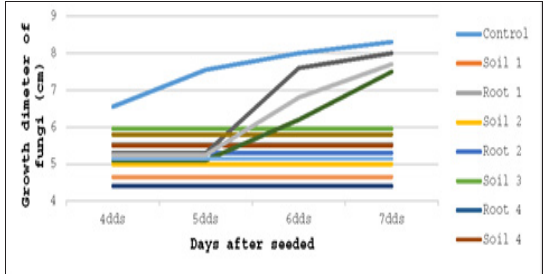
Fig. 1. Advance of P. cinnamomi (in centimeters) against soil and root isolates of Pseudomonas spp. for 7 days after seed in vitro test.